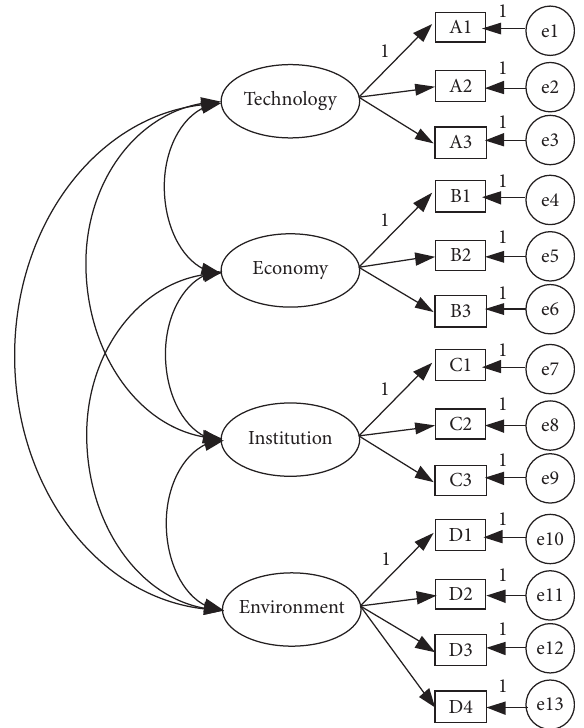
Table 7: Rotating component matrix.